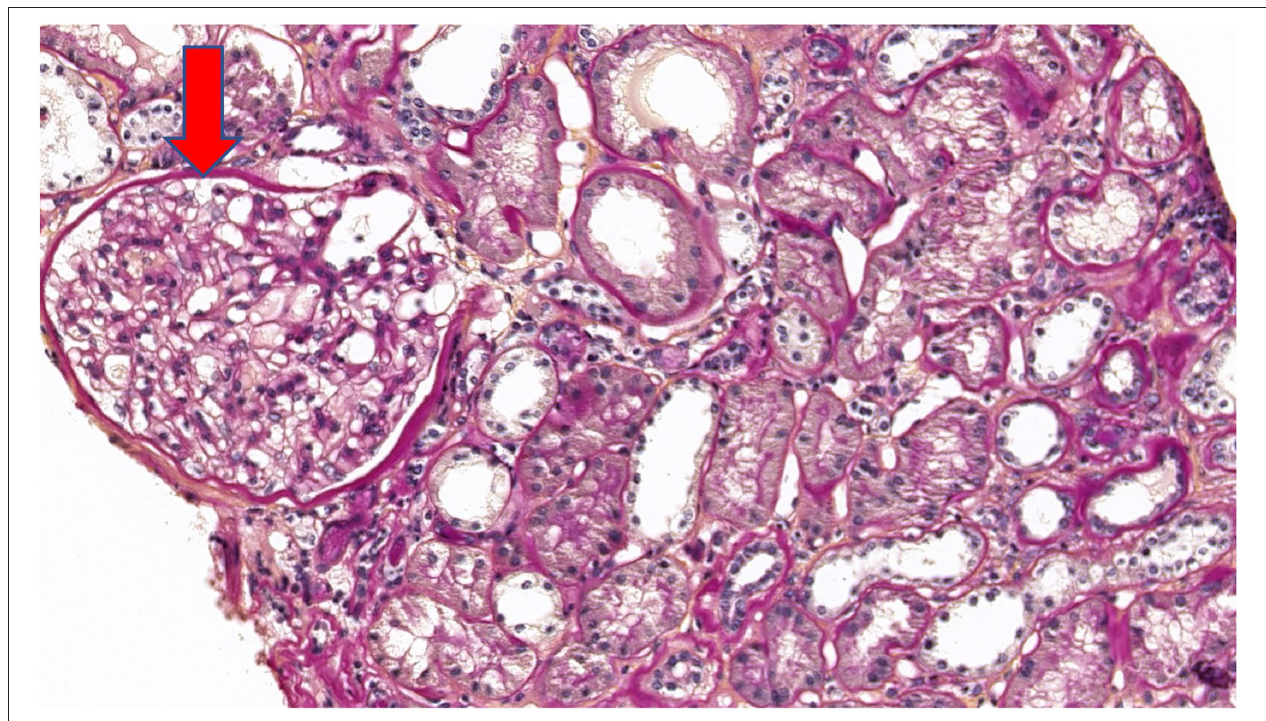
FIGURE 3 | Periodic acid Schiff (PAS) stain at × 20 magnification on light microscopy showing a normal glomerulus (arrow).